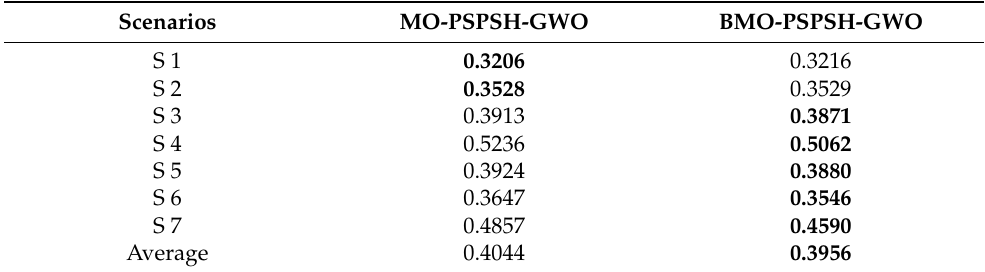
Table 9. Comparison between MO-PSPSH-GWO and BMO-PSPSH-GWO in terms of capacity power limit rate (CPR) reduction.